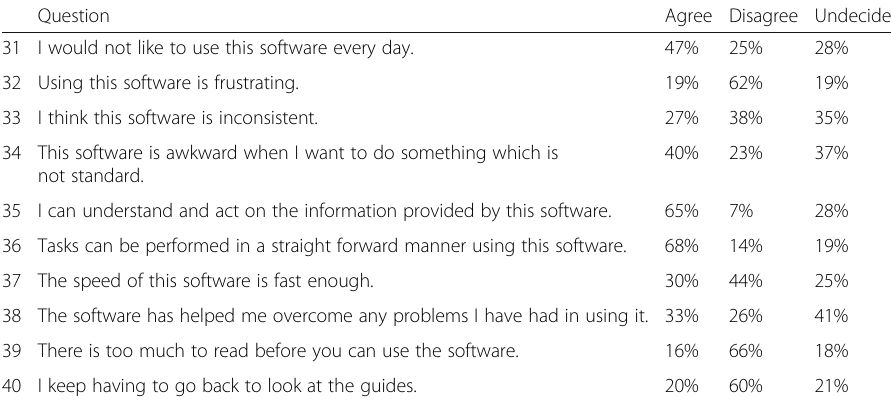
Table 5 Questions 31 – 40 on helpfulness Question Agree Disagree